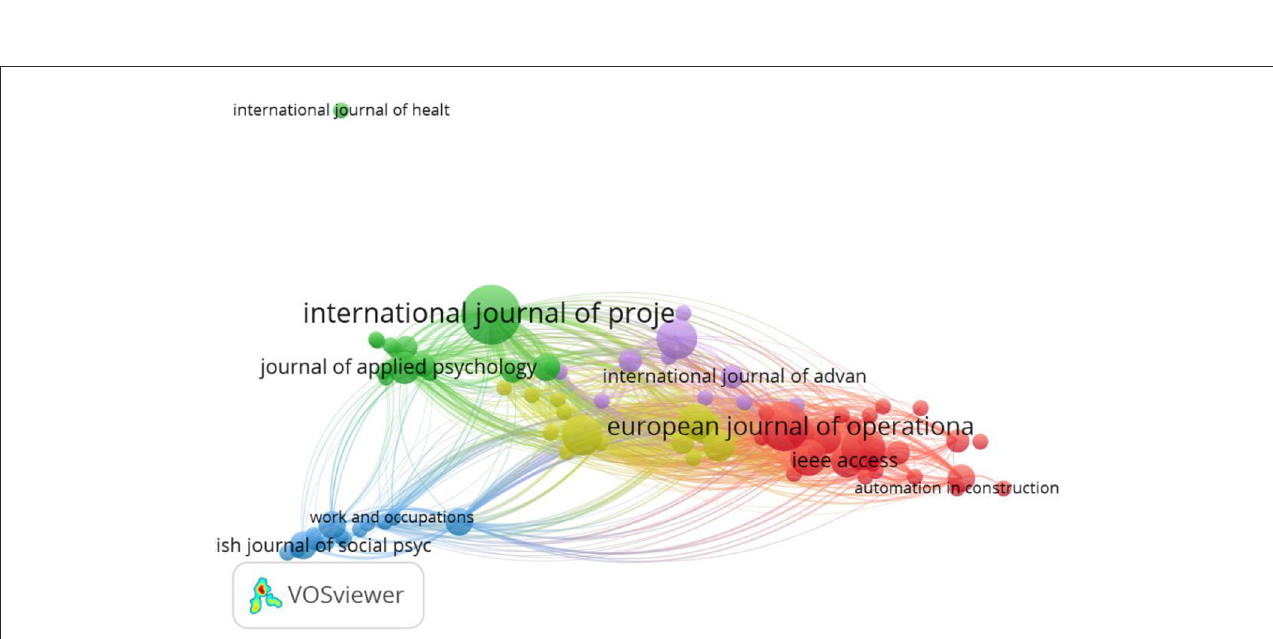
FIGURE6 Bibliographic coupling analysis based on